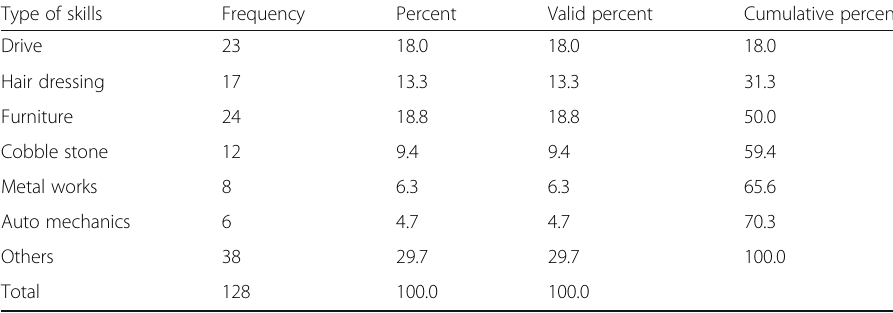
Table 7 Type of skills acquired by the trainees Type of skills